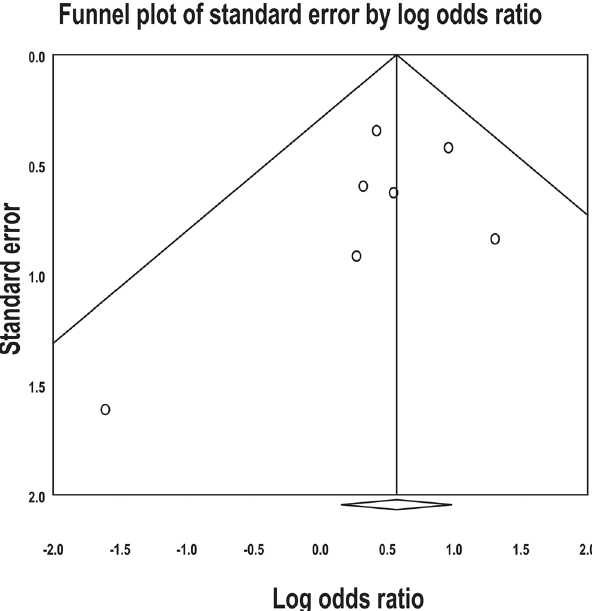
Figure 5. Funnel plot of meta-analysis for the association between MYD88 L265P mutation and age. Individual studies, indicated by small circles, are uniformly distributed in inverted V-shape and indicate no published